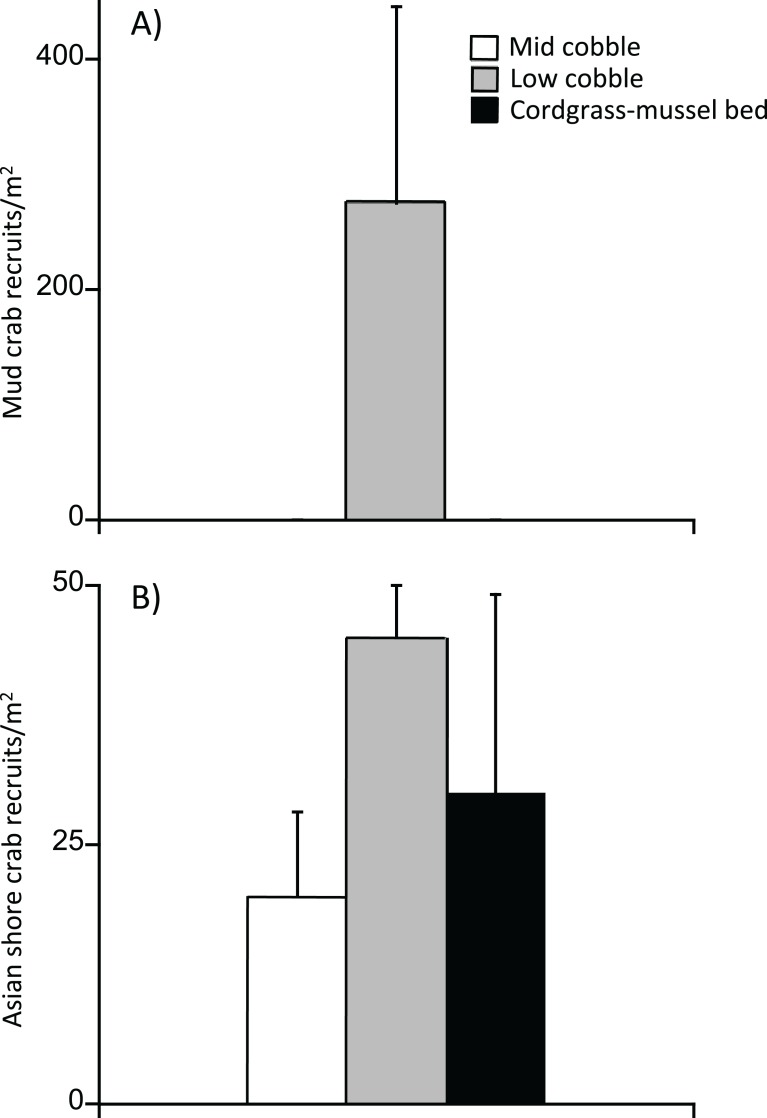
Settlement rates of (A) native mud crabs and (B) invasive Asians shore crabs into mid cobble, low cobble, and cordgrass–mussel bed zones.Data are means + SE.